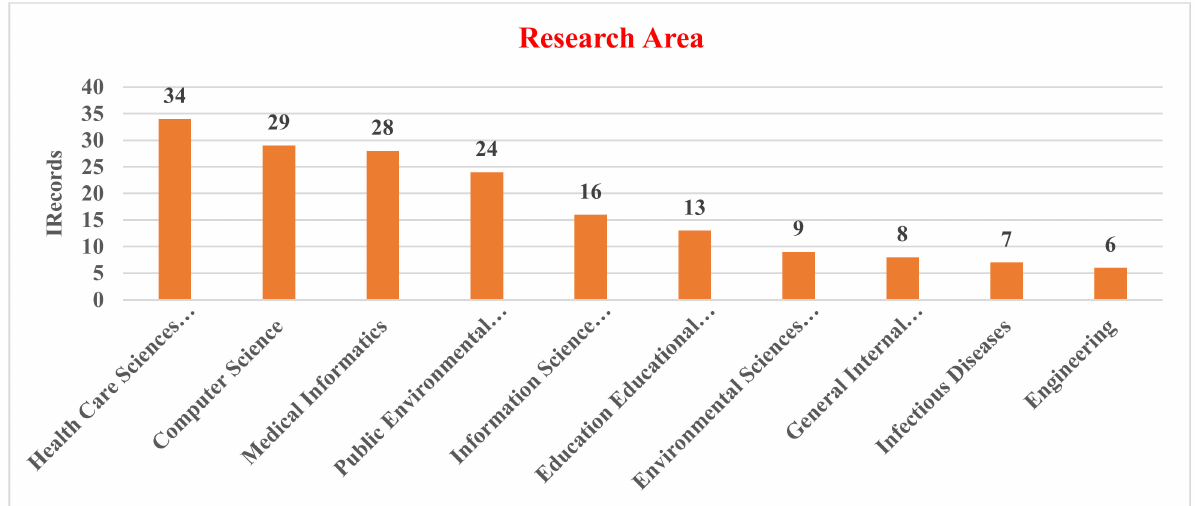
Figure 4. Research area distributions in health science research.